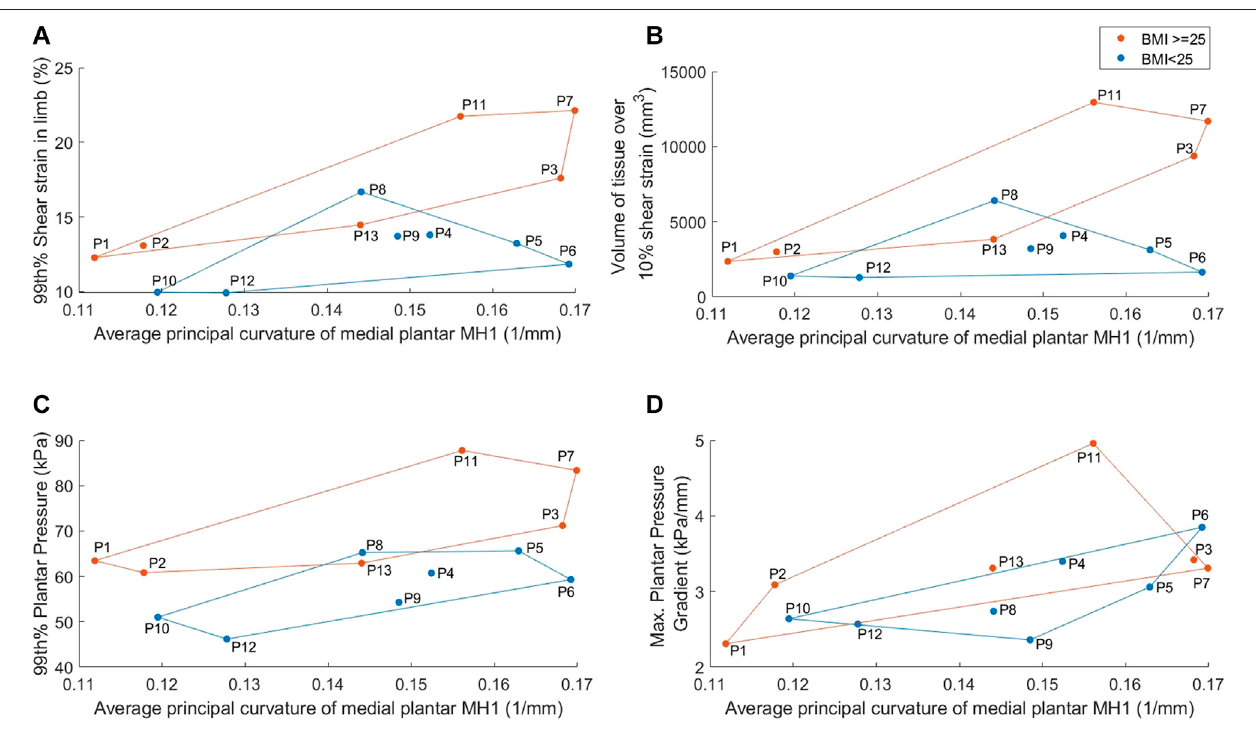
FIGURE6 | Average medial plantar MH1 curvatureresults, separated into normal vs high BMI groups, for: (A) 99th% shear strain in thelimb (B) volume oftissuein the limb over 10% shear strain (C) 99th% plantar pressure (D) maximum plantar pressure gradient. Groups identi fi ed by marker color and convex hull boundaries.